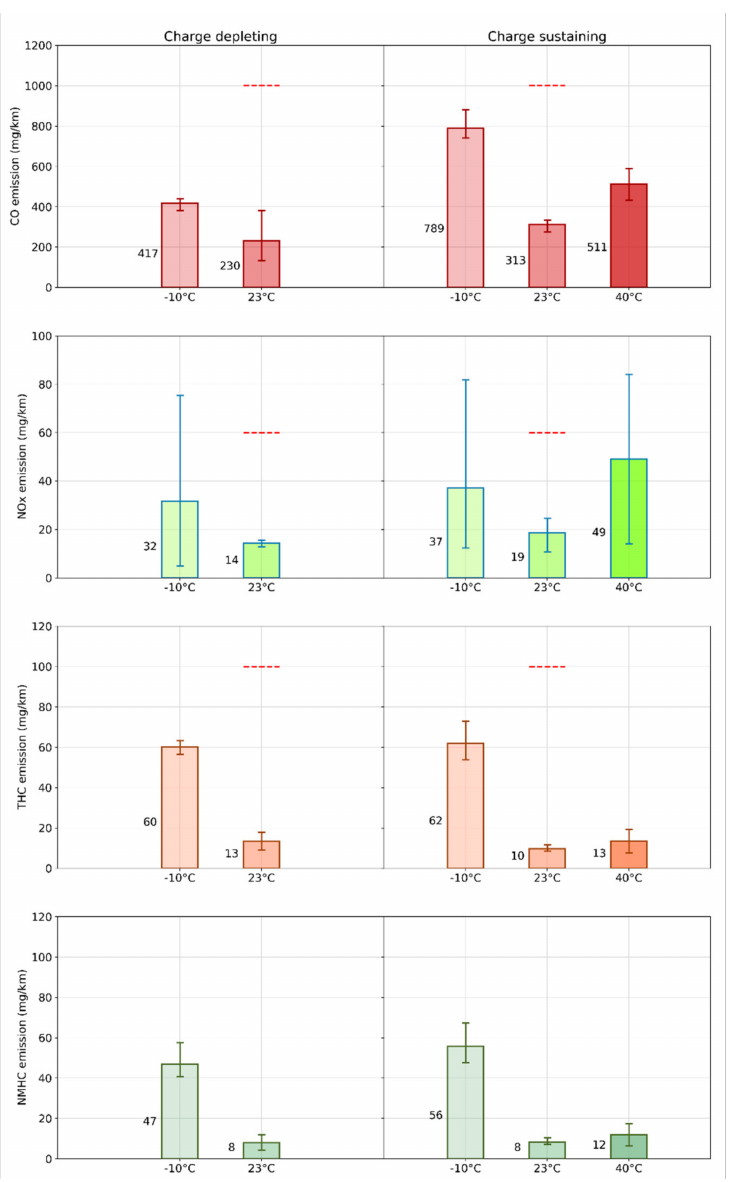
Figure 3. Emissions on WLTC tests as a function of temperature. Emissions at 23 ◦ C are the same as those reported in Figure 1 above and have been included just to ease the comparison. CD indicates the cycle in the charge-depleting sequence, started with an initial battery state of charge (SOC) equal to 100%, in which the internal combustion engine ignited for the first time (3rd at 23 ◦ C, 1st at − 10% ◦ C); CS indicates the cold-start charge-sustaining cycle performed after the battery depleting sequence, i.e., starting with the minimum SOC. All tests were performed in the default user-selectable mode of operation. Error bars on the graph represent maximum and minimum values. See the Methods section for additional